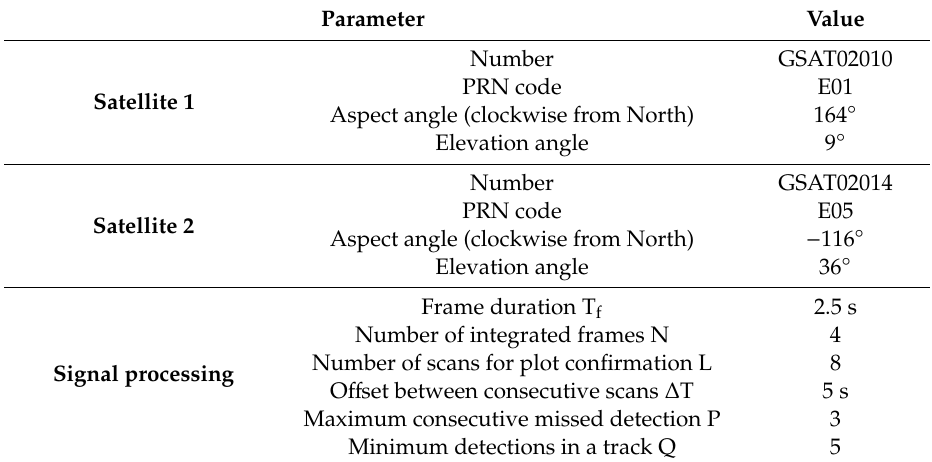
Figure 10. Rhine River: ( a ) acquisition geometry; ( b ) Filia Rheni (passenger ship); ( c ) Godesia (passenger ship); ( d ) Oranje Nassau II (inland motor tanker); and ( e ) Marsja (inland motor tanker). Table 4. Rhine River—experimental and signal processing